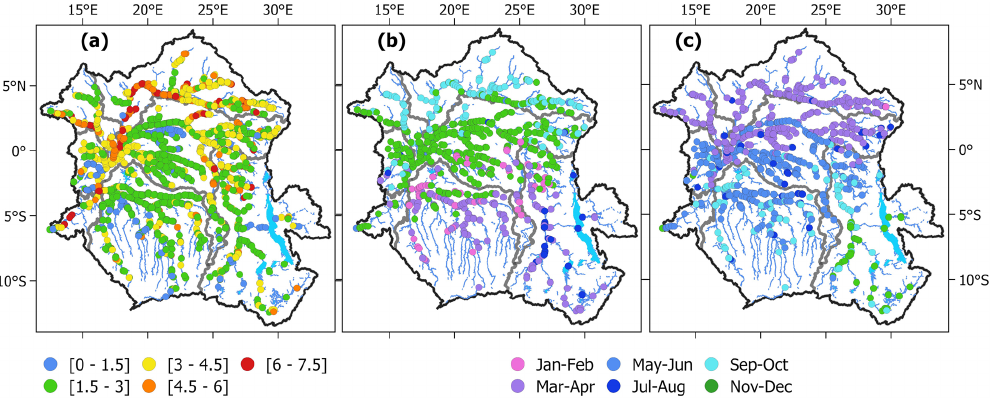
Figure 5. Statistics for radar altimetry VSs. (a) The maximum amplitude of SWH (in metres). (b) The average month of the maximum of SWH. (c) The average month of the minimum of